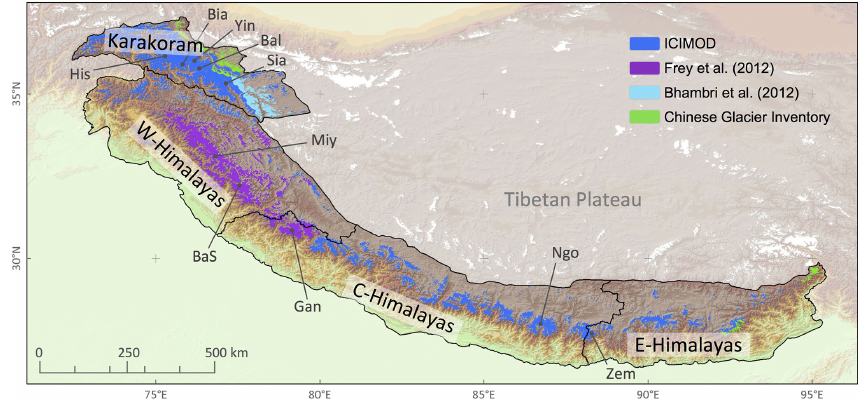
Figure 1. Study region and sources of the glacier inventory used for this study. The largest glaciers of each sub-region are indicated, see Table 4 for glacier names and